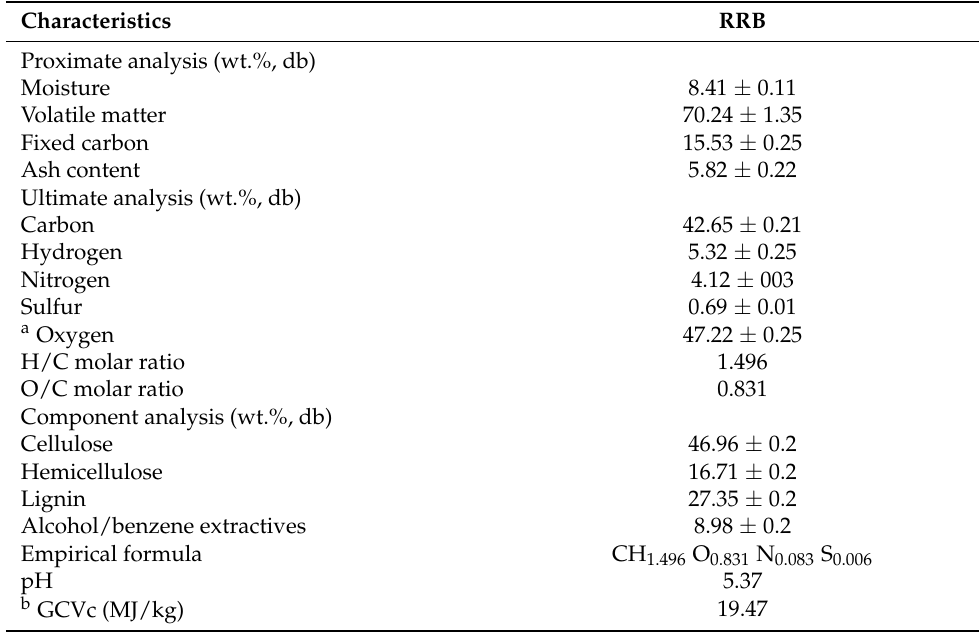
Table 1. Proximate, ultimate and component analysis of rapeseed residual biomass (RRB). Characteristics RRB Proximate analysis (wt.%,